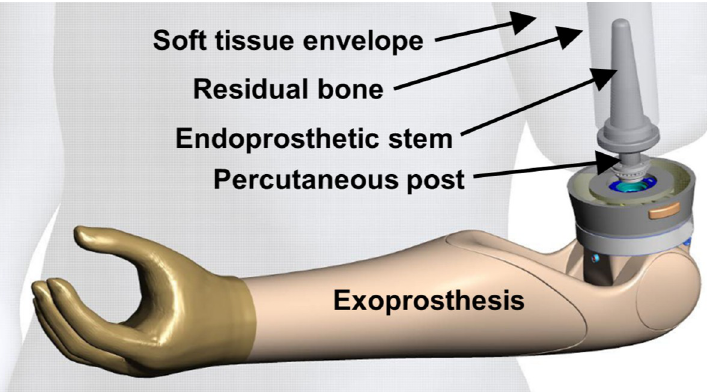
Fig 1. Schematic of a percutaneous osseointegrated prosthetic system for transhumeral amputation. An endoprosthesis placed in the residual humerus passes through the skin to support the exoprosthetic forearm and hand. This system obviates the need for typical socket suspension that interfaces to the soft tissues of the residual limb. Reprinted under a CC BY license, with permission from Motion Control Inc, a Fillauer Company.